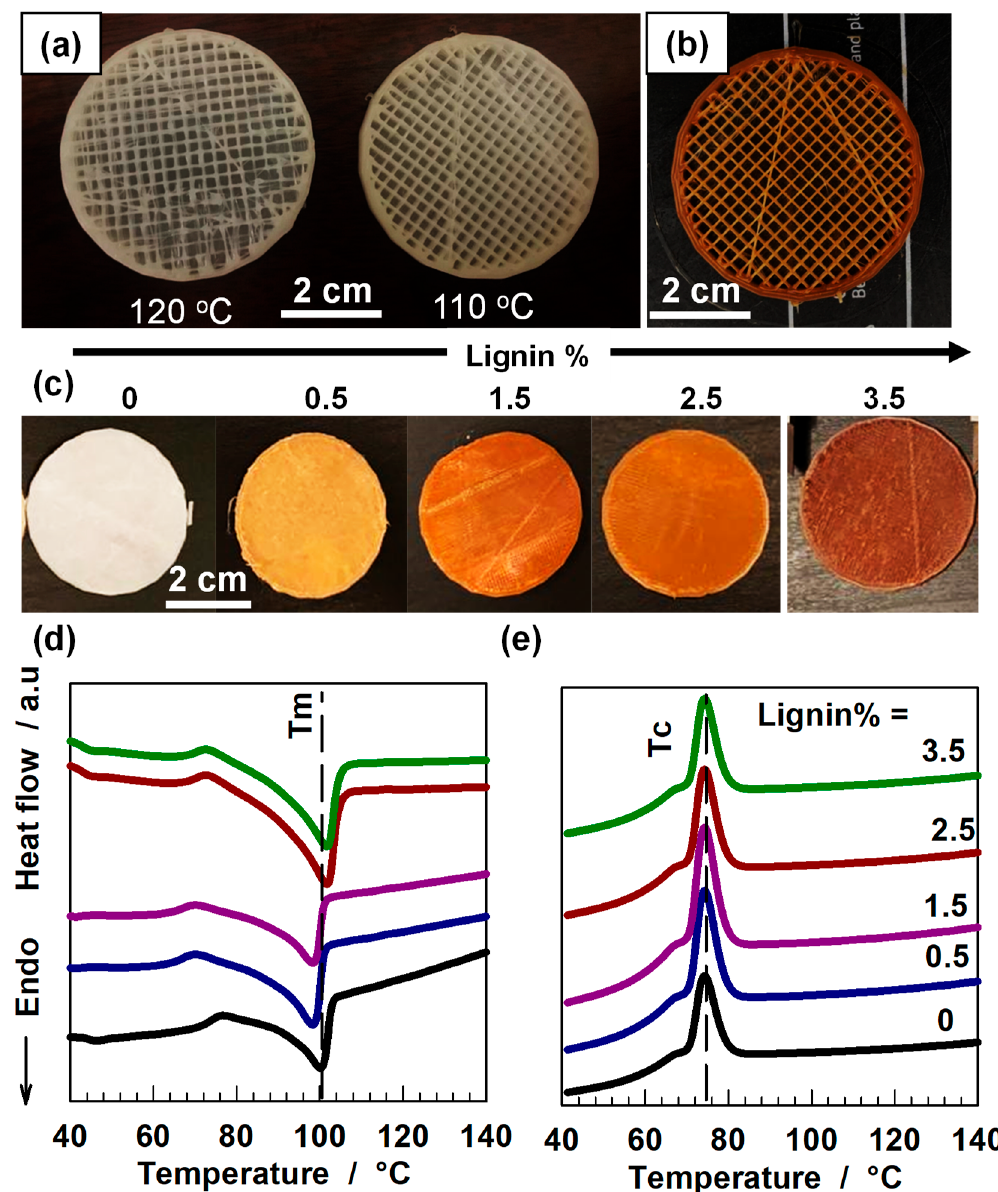
Figure 2. ( a ) Printing quality of PBS at different extrusion temperatures. ( b ) the printing quality of the composite with 2.5% lignin at 110 °C. The original CAD was designed as a circular shape within square networks. ( c ) The appearance of printed composites with different mass fractions of lignin.